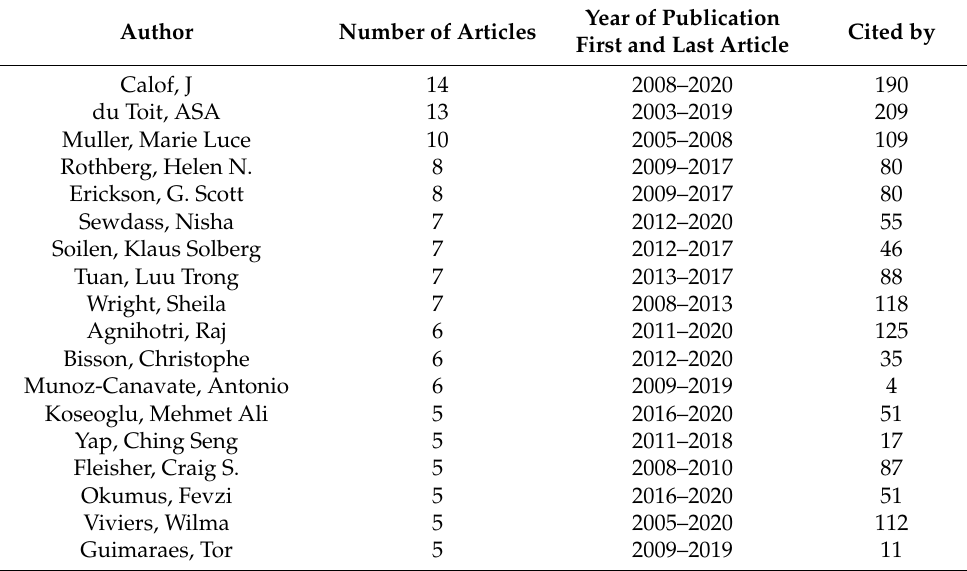
Table 1. Authors who have published five or more articles on Competitive